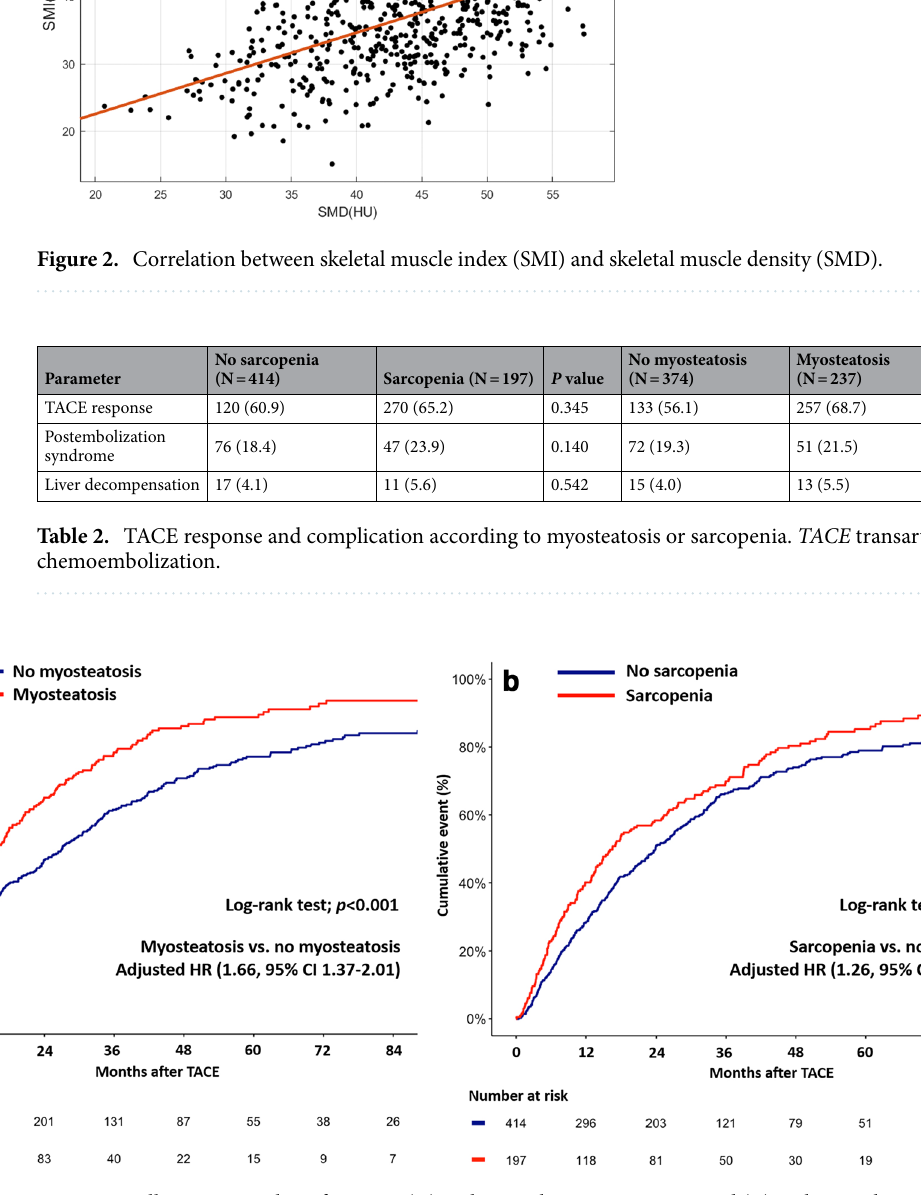
Figure 3. All-cause mortality of patients ( A ) with or without myosteatosis and ( B ) with or without sarcopenia. *adjusted by age, chronic lung disease, and chronic kidney